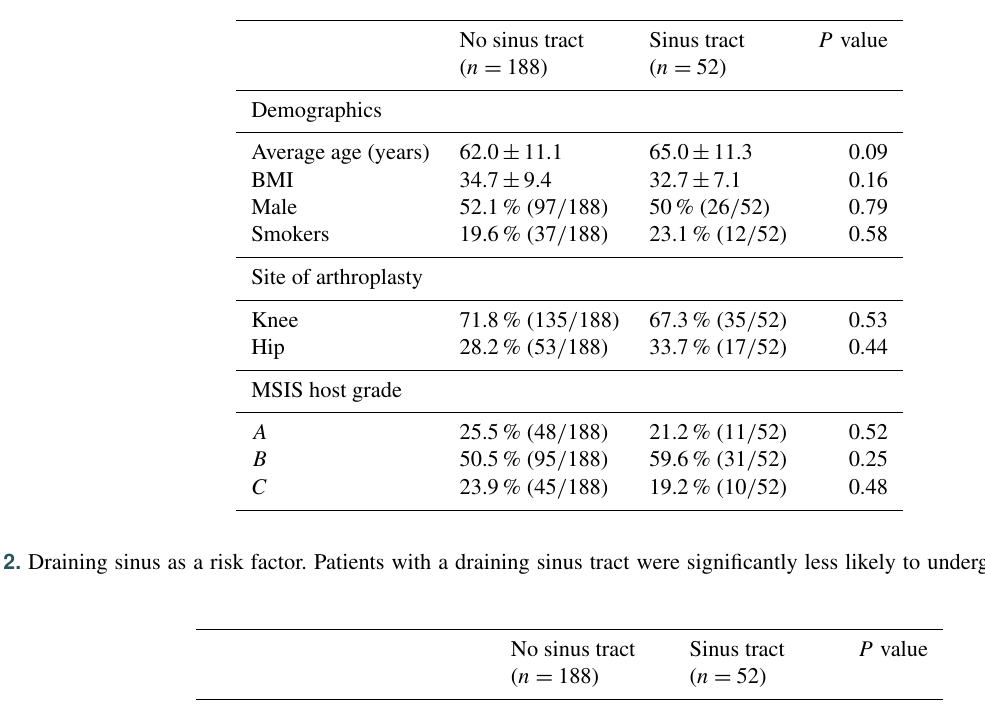
Table 1. Patient demographics. In total, 240 patients were treated for prosthetic joint infection of either the hip or the knee with intended two-stage exchange arthroplasty (all p> 0 . 05).